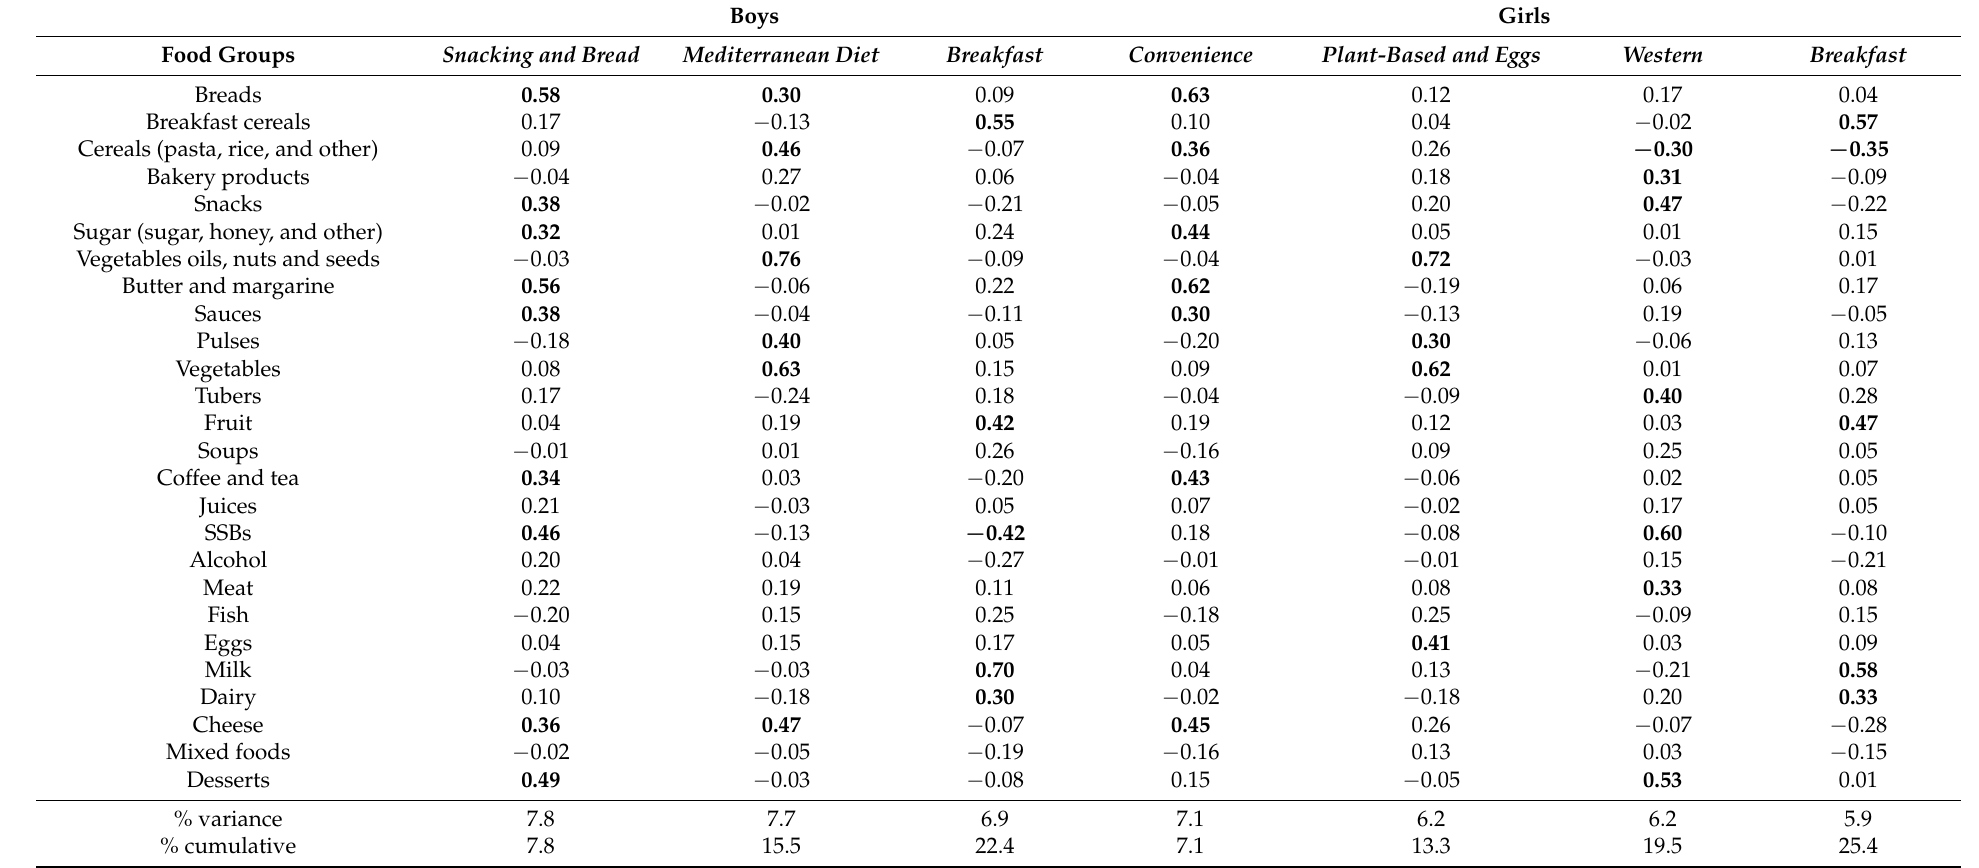
Table 2. Factor loadings of dietary patterns of European adolescents, according to sex. HELENA